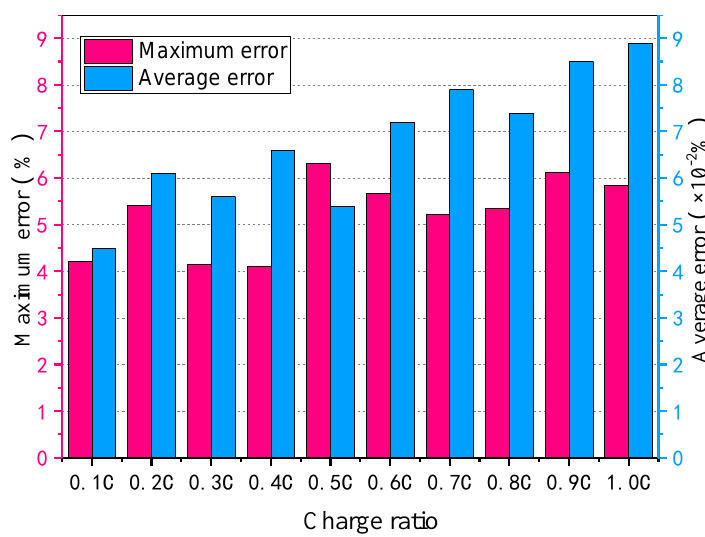
Figure 5. Comparison between the errors of the calculated value and the test result of the equivalent circuit model.